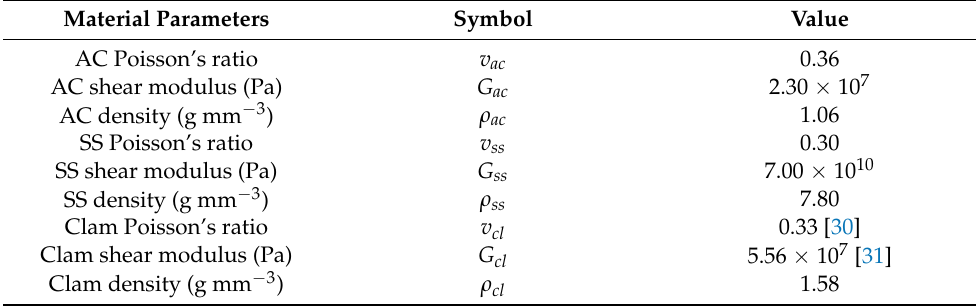
Table 1. The initial set of material parameters for AC, SS, and Clam.